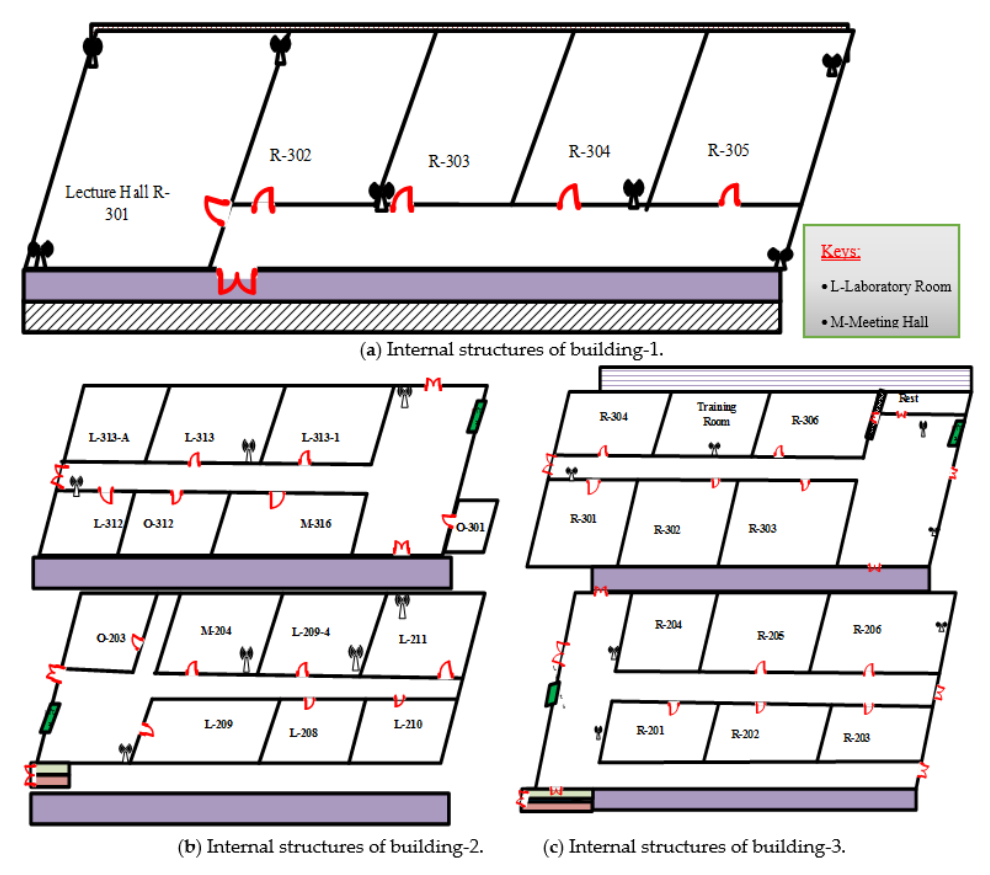
Figure 1. Structures of the indoor environments.